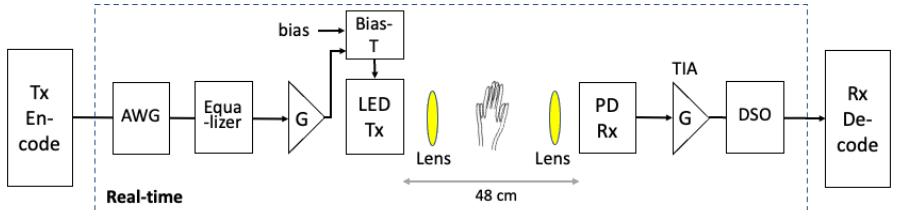
Figure 5. VLC system block diagram showing the real-time transceiver and offline encoding and waveform